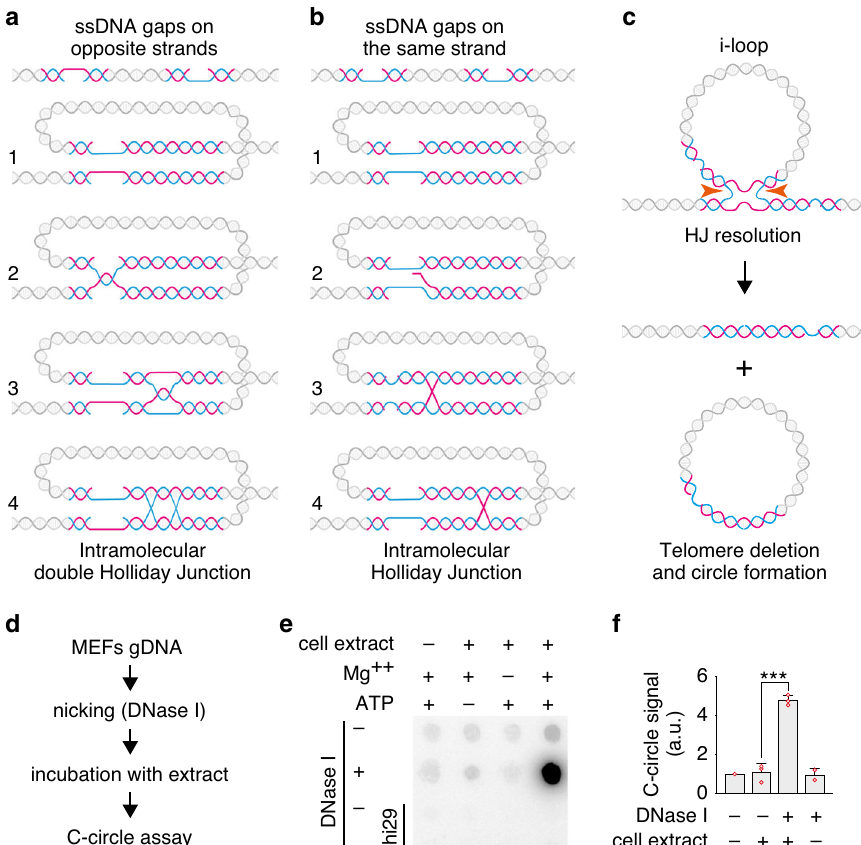
Fig. 7 I-loops are a substrate for the generation of telomeric circles. a Formation of i-loops, by gaps on opposite telomeric strands. Exposed complementary DNA can come in close proximity by looping and undergo base pairing (step 1). Plectonemic pairing can occur by strand rotation, resulting in an i-loop (step 2). The loop junction could branch migrate as a hemicatenane (step 3) that could be transformed in a double Holliday junction by pairing of the opposite strands (step 4). b Formation of i-loops, by gaps on the same telomeric strand. The gaps can come in close proximity by DNA looping (step 1) and promote an exchange of the complementary strands (step 2) resulting in an i-loop with a single Holliday junction at the base (step 3), that can undergo branch migration (step 4). c Generation of telomeric circles via i-loop excision by Holliday junction resolvases. Cleavage on the horizontal axis of the image (orange arrows) will result in the excision of the loop as a circle and telomere loss. Note that the excised circle, would contain a nick, resulting from the HJ resolution and one of the original single-stranded gaps that induced formation of the i-loop. d Experimental procedure to test the model shown in ( c ). Isolated SV40-LT MEFs genomic DNA was nicked with low concentrations of DNase I, which induces the formation of i-loops at telomeres. The DNA was extracted, incubated for 30 min at 37 °C with a HeLa nuclear extract to allow HJ resolution and the presence of telomeric circles was assayed with the C-circle assay. e Dot blot of the C-circle assay in (d) hybridized with a probe recognizing the telomeric repeats. Source data are provided as a Source Data File. f Quanti fi cation of the telomeric signal in dot blots from 3 independent experiments as the one described in d . Bars represent the mean with the standard deviation. Single data points are also shown as red dots. The signal is reported relative to the untreated sample (no DNase I, no extract) which was set to 1. P value = 0.0003, was derived from unpaired, two-tailed, Student ’ s t -test. Source data are provided as a Source Data